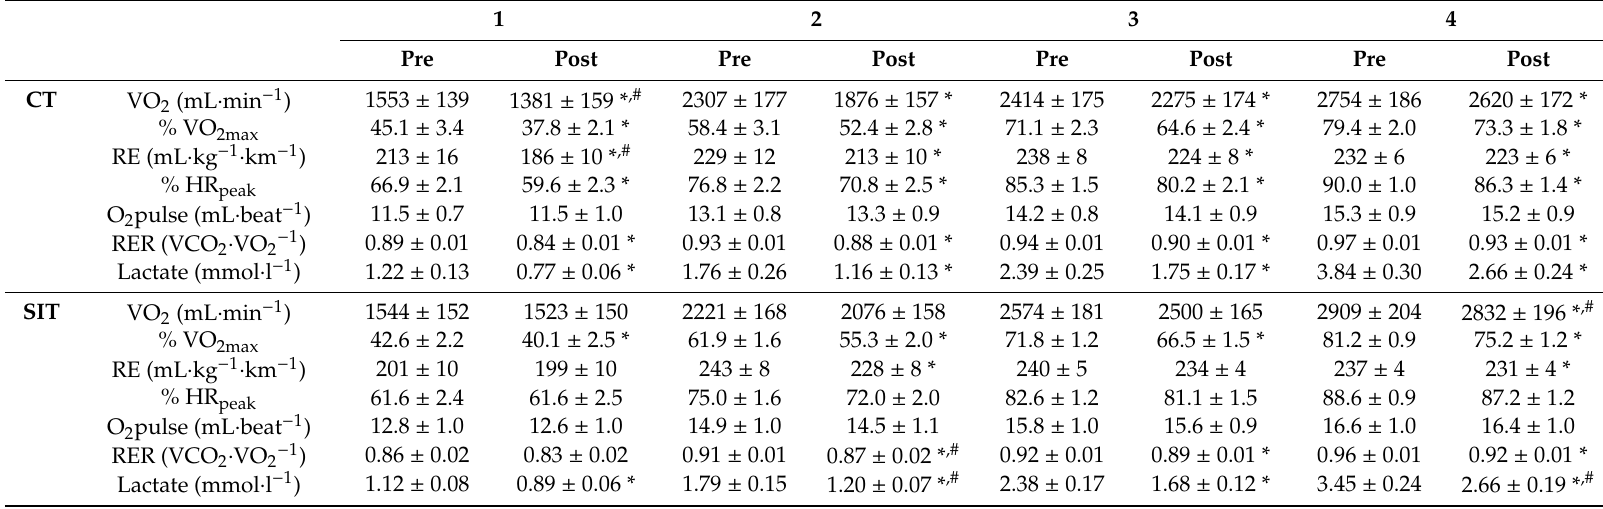
Table 3. Physiological responses at submaximal velocities, before (pre) and after (post) eight weeks of either continuous training (CT) or sprint interval training